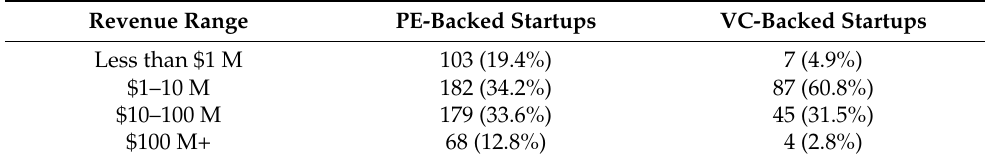
Table 4. PE and VC-backed Startups by Revenue Size. Revenue